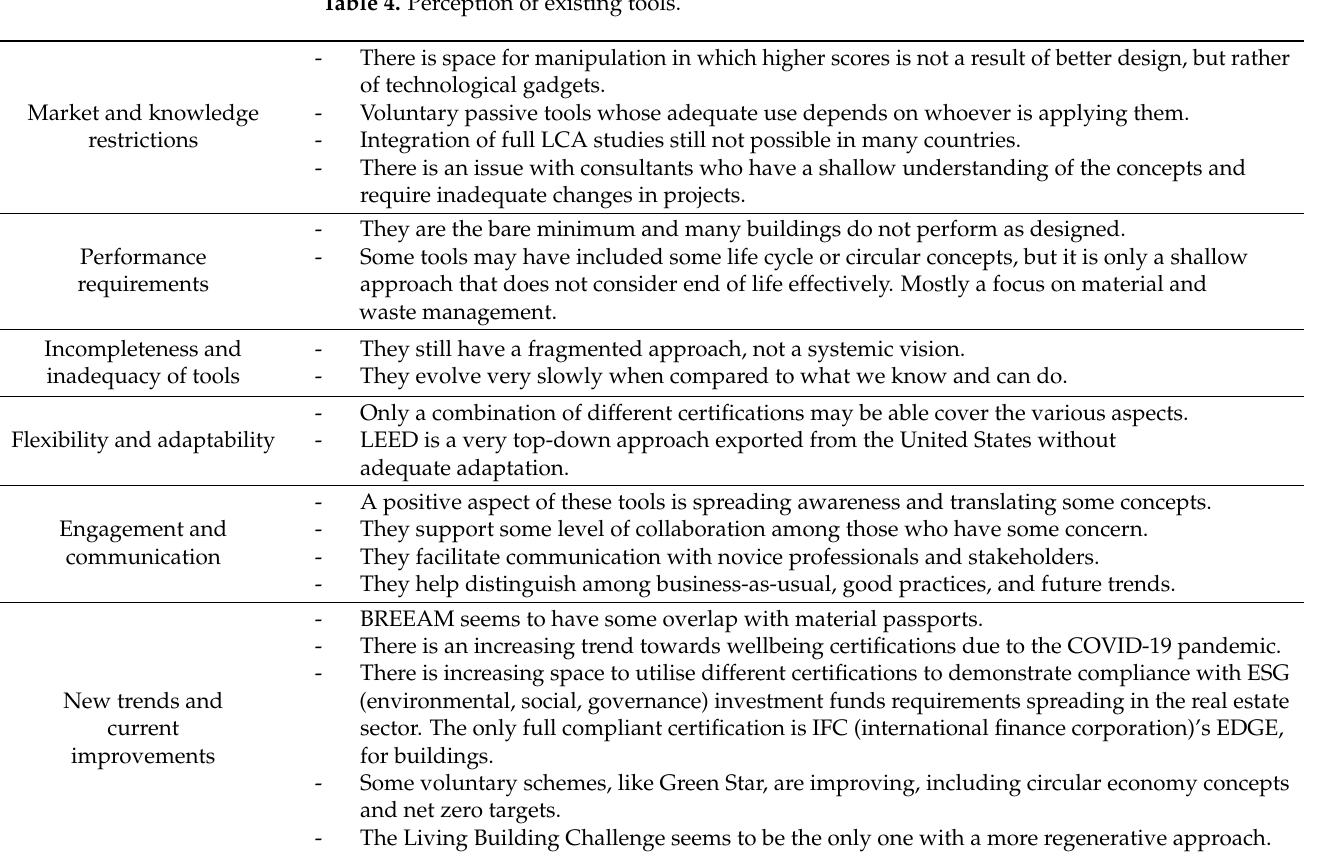
Table 4. Perception of existing